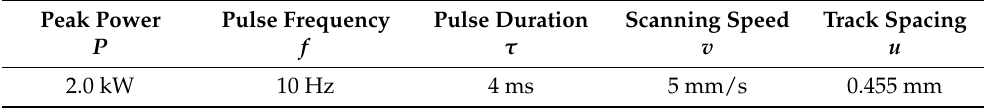
Table 1. Laser cladding